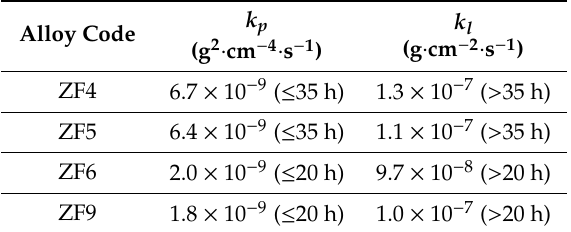
Figure 10. BSE images showing the typical microstructure of a cross-section of the alloy ZF9 after oxidation in air at 800 °C for 100 h: ( a ) ×200, ( b ) ×2000, and ( c ) ×10000. Table 7. Oxidation rate constants of the alloys at 1200 ◦